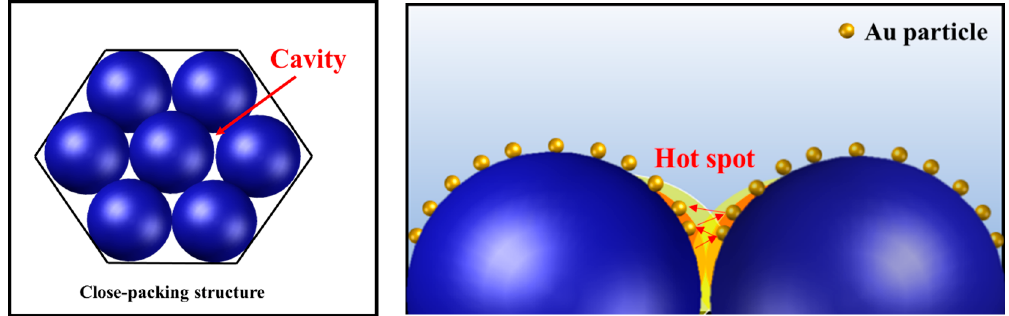
Figure 8. Silica-based PC films as a substrate for the Au thin film for surface-enhanced Raman scattering (SERS).